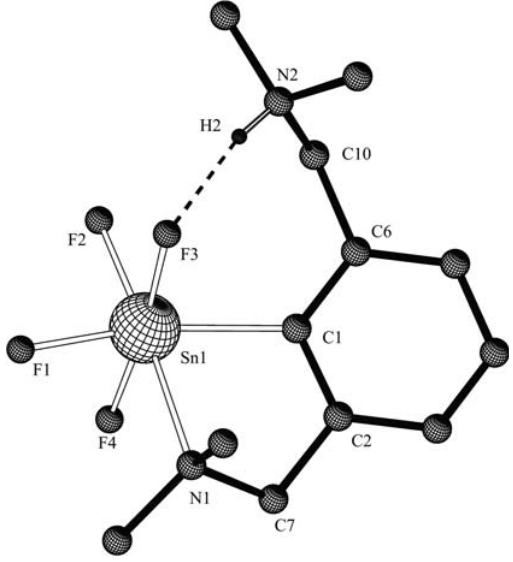
- ]. Hydrogen atoms 4